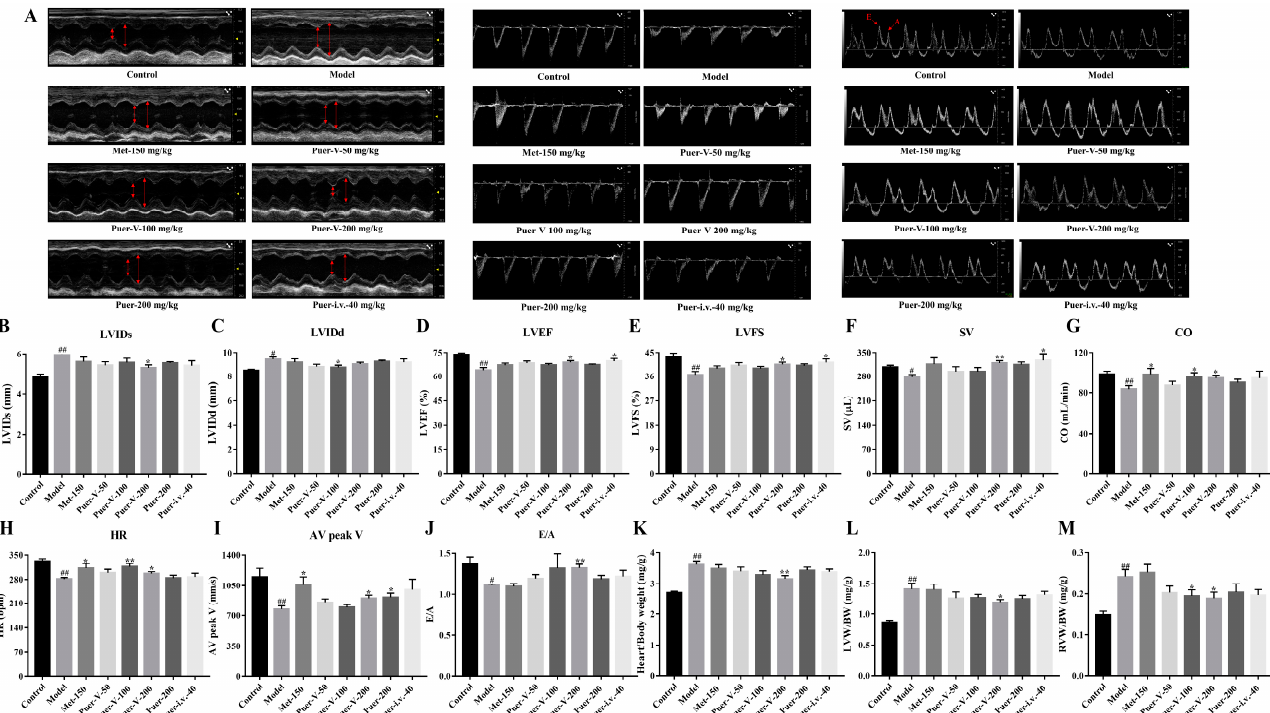
Figure 5. Puerarin-V ameliorated cardiac function in the DCM rats. ( A ) Representative echocardiographic M-mode records of left ventricular wall and Doppler images of aortic flow. Effects of Puerarin-V on LVIDs ( B ), LVIDd ( C ), LVEF ( D ), LVFS ( E ), SV ( F ), CO ( G ), HR ( H ), AV peak V ( I ), and E/A ratio ( J ). ( K ) The heart weight/body weight ratio. ( L ) The left ventricular weight/body weight ratio. ( M ) The right ventricular weight/body weight ratio. The data are represented by mean ± SEM (n = 6–8). # p < 0.05 and ## p < 0.01 vs. control group. * p < 0.05 and ** p < 0.01 vs. model